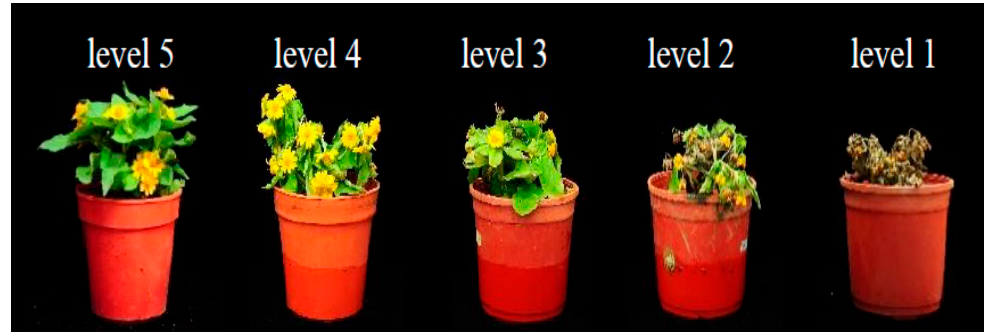
Figure 1. Conditions of the tested plants under 10 days of waterlogging as scored by plant quality. Level 5 (5 points): normal growth without any injured morphological appearance of the tested plants under 10 days of waterlogging. Level 4 (4 points): one or two leaves had become brown and withered. Level 3 (3 points): three or four leaves had become brown, withered, and defoliated. Level 2 (2 points): five or six leaves had become brown, withered, and defoliated. Level 1 (1 point): all leaves had become brown, withered, and defoliated. A score of 5 (level 5) indicates good performance, and a score (level) ≥ 3 indicates ornamental